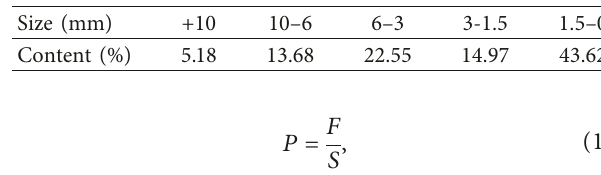
Table 4: Coal gangue particle size